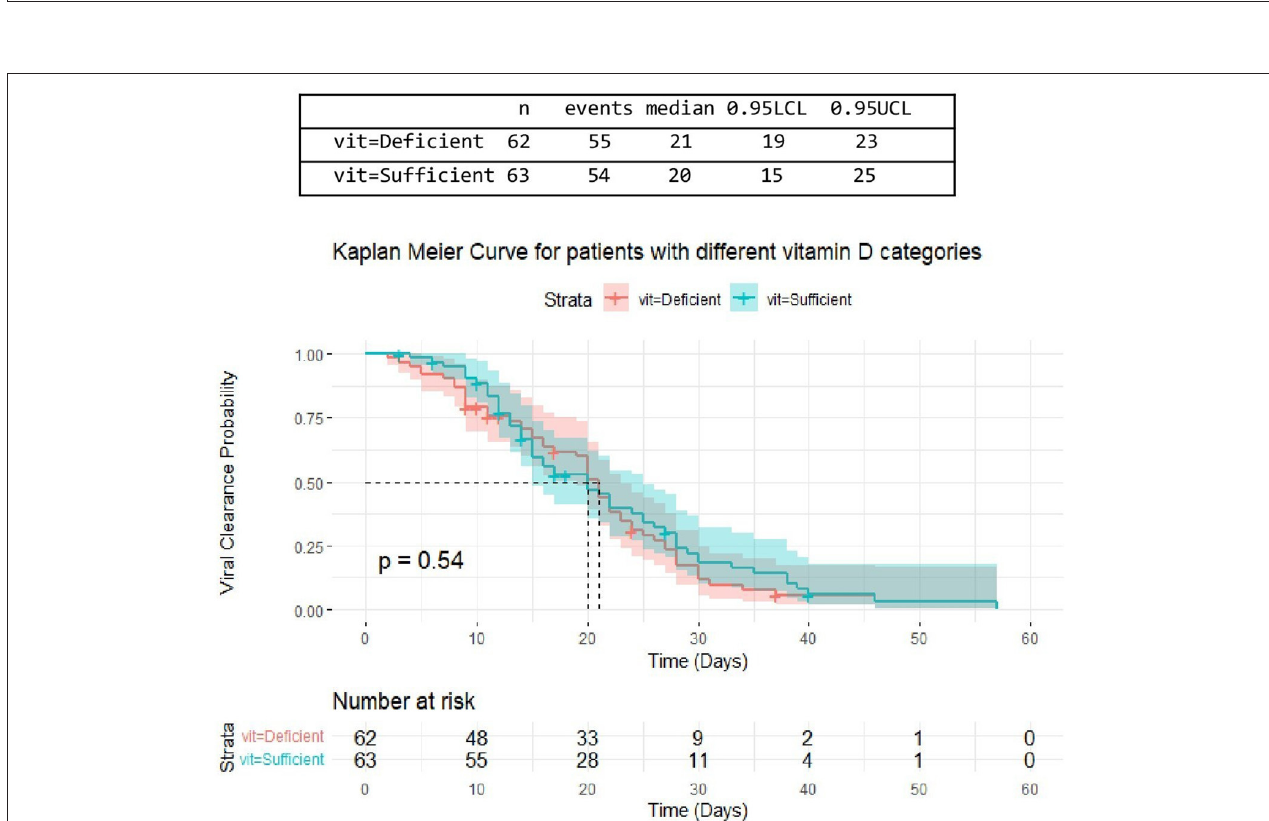
FIGURE 4 | The association between serum 25(OH)D levels (sufficient, deficient) and time untill viral clearance.